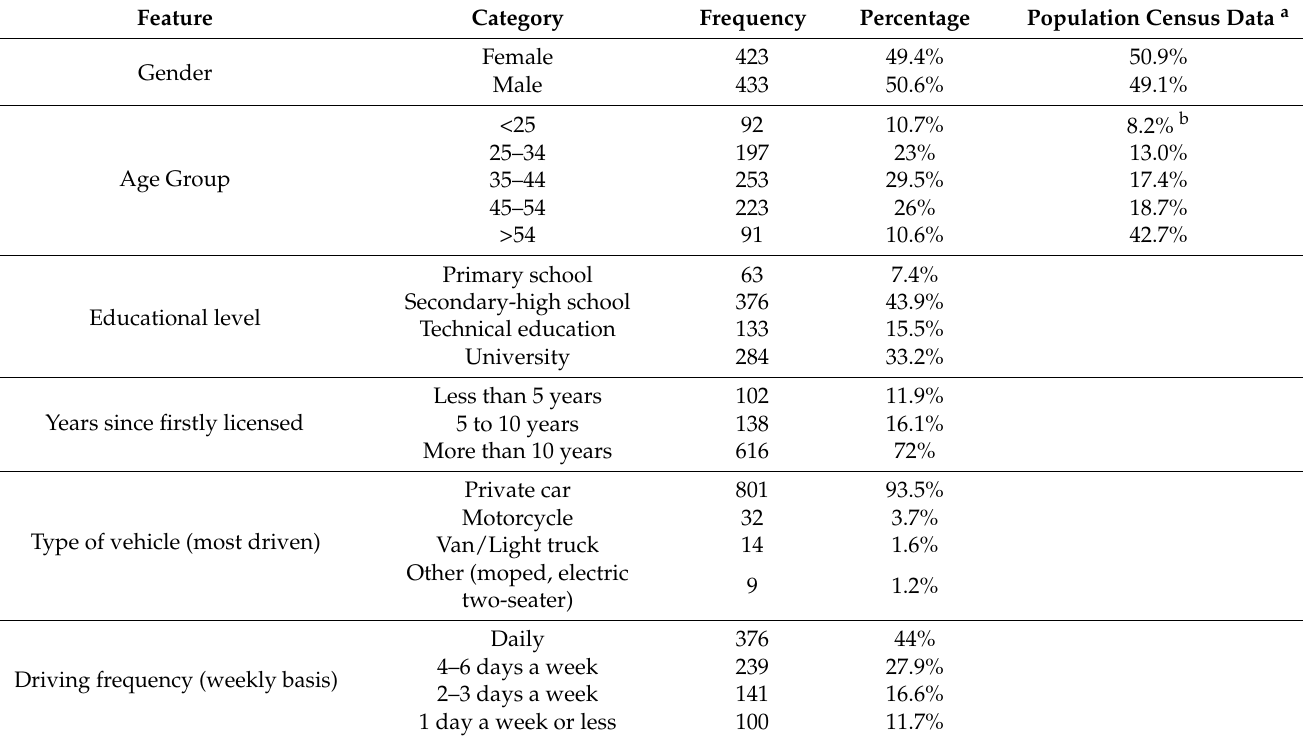
Table 1. Study partakers’ sociodemographic data and basic driving